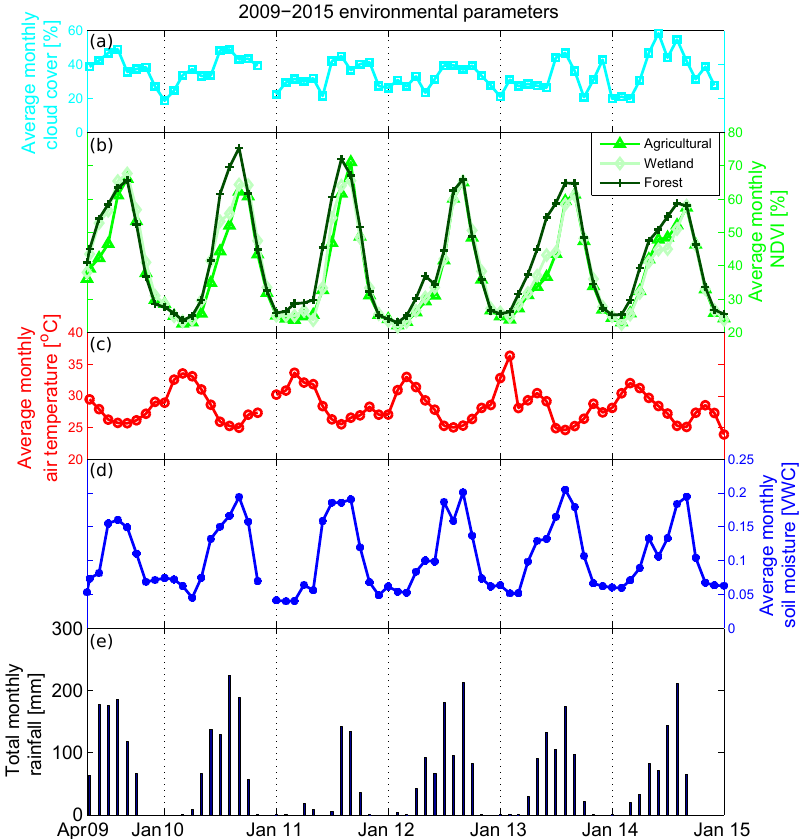
Figure 2. Environmental parameters at the study site for the monitoring period (2009–2015): (a) cloud cover measured with shortwave radiometers and averaged over all stations; (b) average NDVI from MODIS satellite data (250m resolution, 10-day composite) averaged over each land cover of pixels containing stations; (c) monthly average air temperature (red line), also averaged for all stations; (d) volumetric soil moisture averaged over all stations and all land covers between 5 and 30cm depth (blue line); and (e) monthly rainfall (missing bars indicate lack of